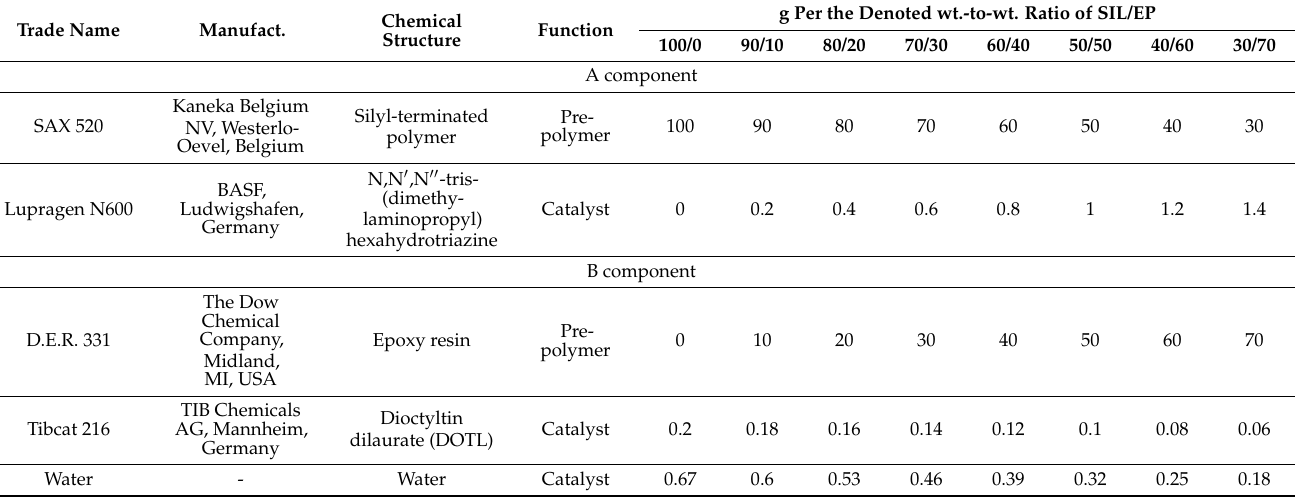
Table 1. Characterization of two-component SIL/EP formulations (model system without compatibilizer).